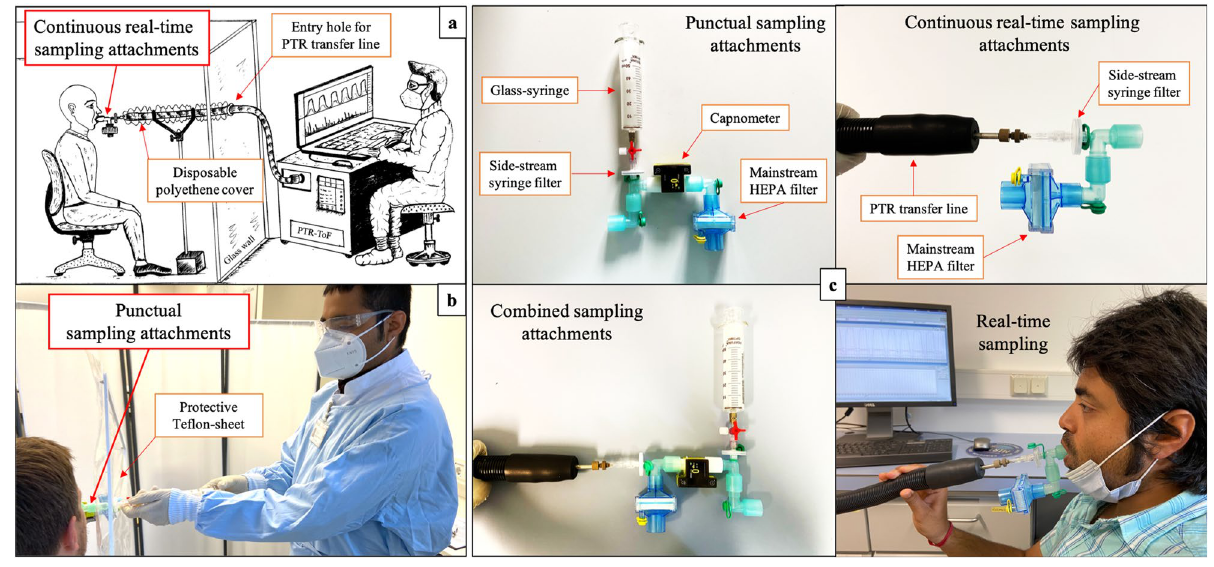
Figure 6. General setups for continuous real-time ( a ) and offline ( b ) sampling and customised viral filter attachments ( c ). In compliance to infection safety mandates, general setups for online and offline sampling are optimised. Punctual sampling in glass-syringe and direct continuous real-time sampling in PTR-ToF–MS are adapted via customised viral filter attachments. Combined sampling attachments to conduct simultaneous real- time and offline sampling are also